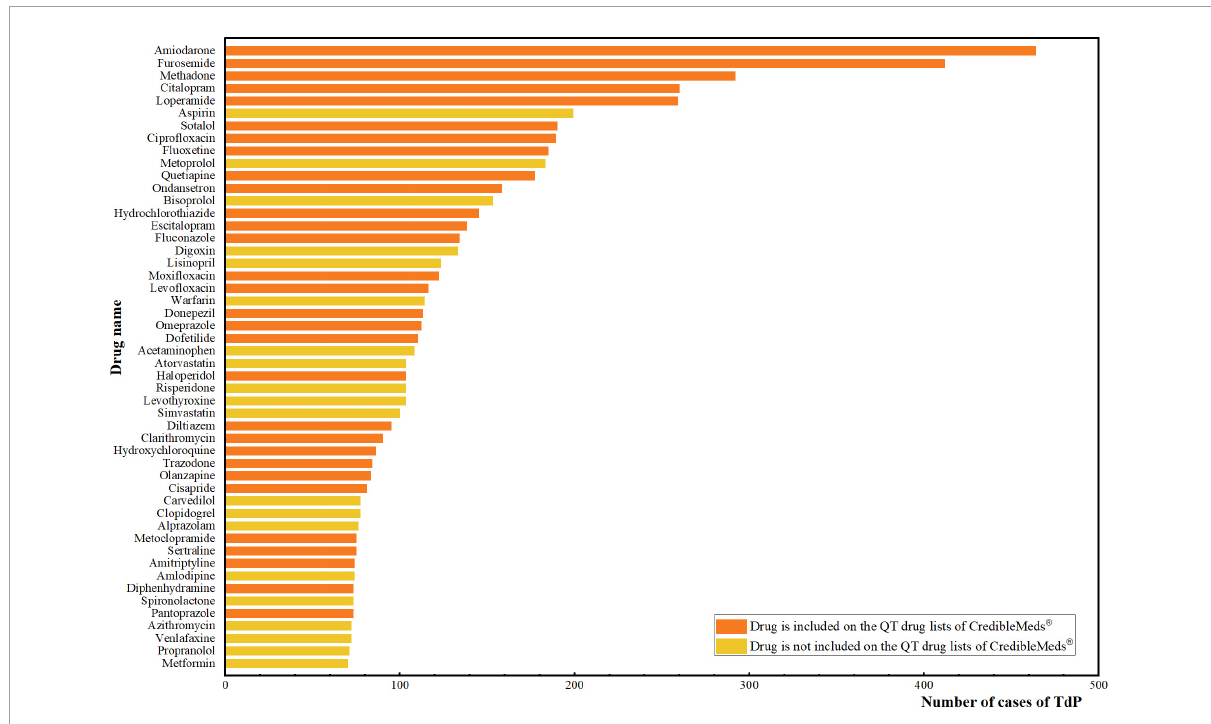
FIGURE1 Top 50 drugs with the most number of cases of TdP. The vertical axis is the name of the drugs, and the horizontal axis is the corresponding number of cases of TdP for each drug. The orange color represents that the drug is included on the QT drug lists of CredibleMeds R (cid:13) . The yellow color represents that the drug is not included on the QT drug lists of CredibleMeds R (cid:13)